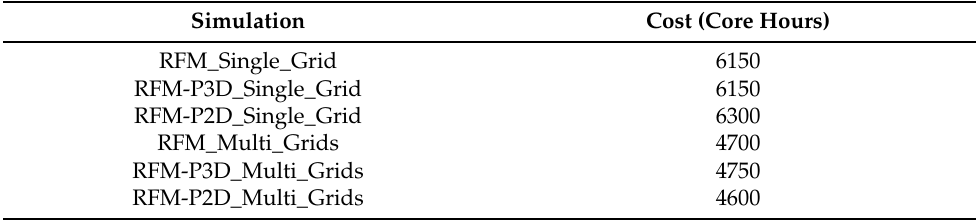
Table 4. Computational cost of each